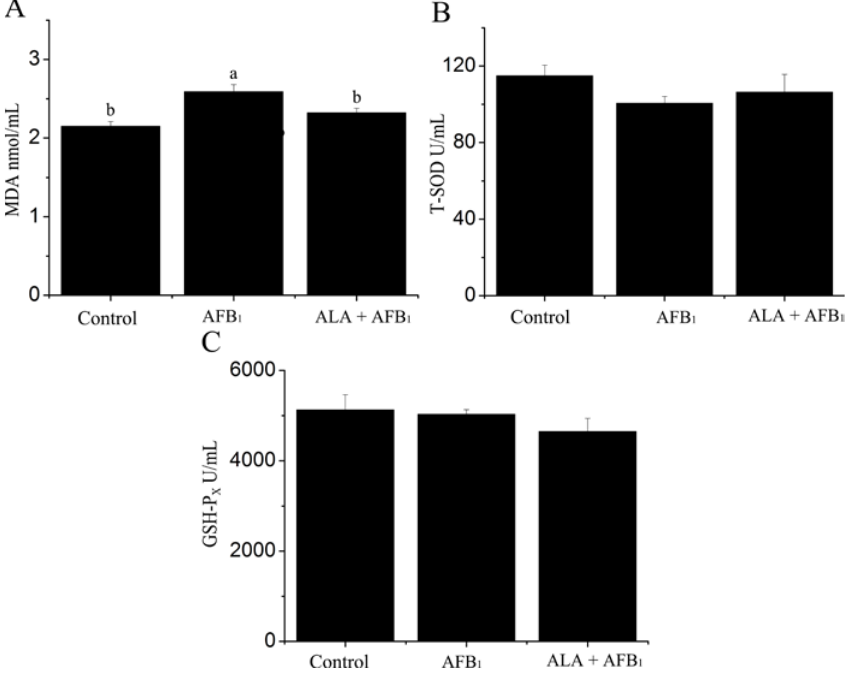
Figure 1. Effect of alpha-lipoic acid (α-LA) on serum antioxidant parameters in broilers fed a diet containing aflatoxin B (AFB ). Lipid peroxidation marker: ( A ) MDA 1 1 (malondialdehyde); Antioxidant enzymes: ( B ) T-SOD (total superoxide dismutase) and ( C ) GSH-P (glutathione peroxidase). ( n = 6). a,b Means with different letters are X significantly different, p <